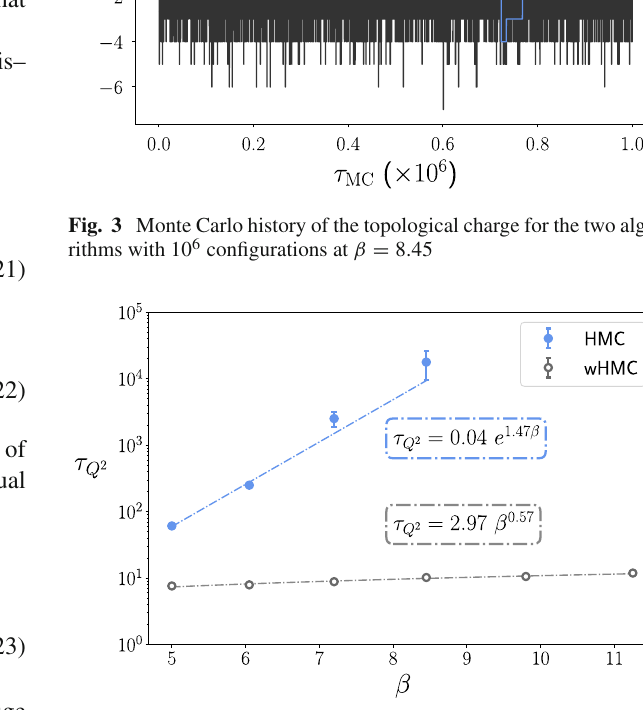
Fig. 4 Autocorrelation time of Q 2 as a function of β ∝ a − 2 , as obtained with the wHMC and HMC